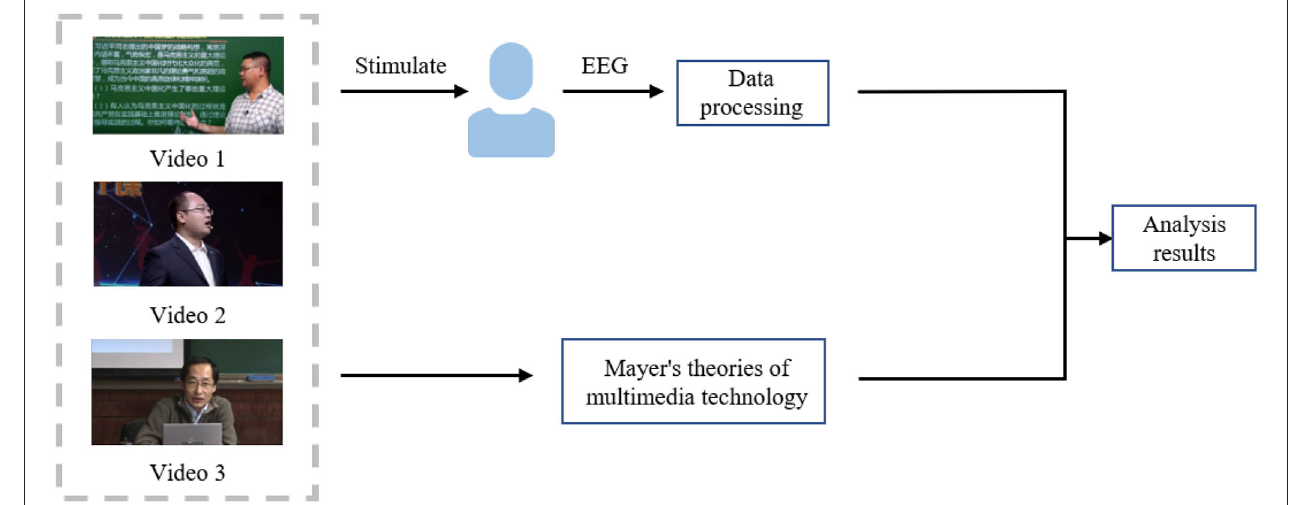
FIGURE 1 | The framework of our work.